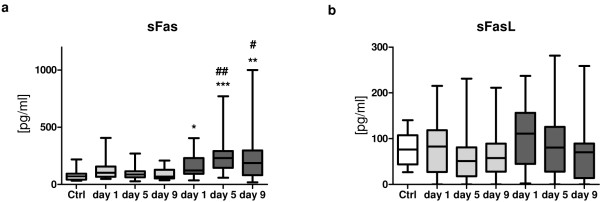
Kinetics of serum soluble Fas (sFas) and soluble Fas ligand (sFasL) after major trauma. (a) sFas levels in patients who developed sepsis during the first 10 days after trauma (n = 18, dark gray boxes) are significantly elevated when compared to the values determined in patients with uneventful recovery (n = 29, light gray boxes) and healthy volunteers (n = 17, white box). (b) No alterations in sFasL levels were observed between different groups. The horizontal line across the boxplots represents the median, and the lower and upper ends of the boxplots are the 25th and 75th percentiles, respectively. Whiskers indicate the minimum and maximum values, respectively. *P < 0.05, **P < 0.01, ***P < 0.001 vs. control group; #P < 0.05, ##P < 0.01 vs. nonsepsis group.